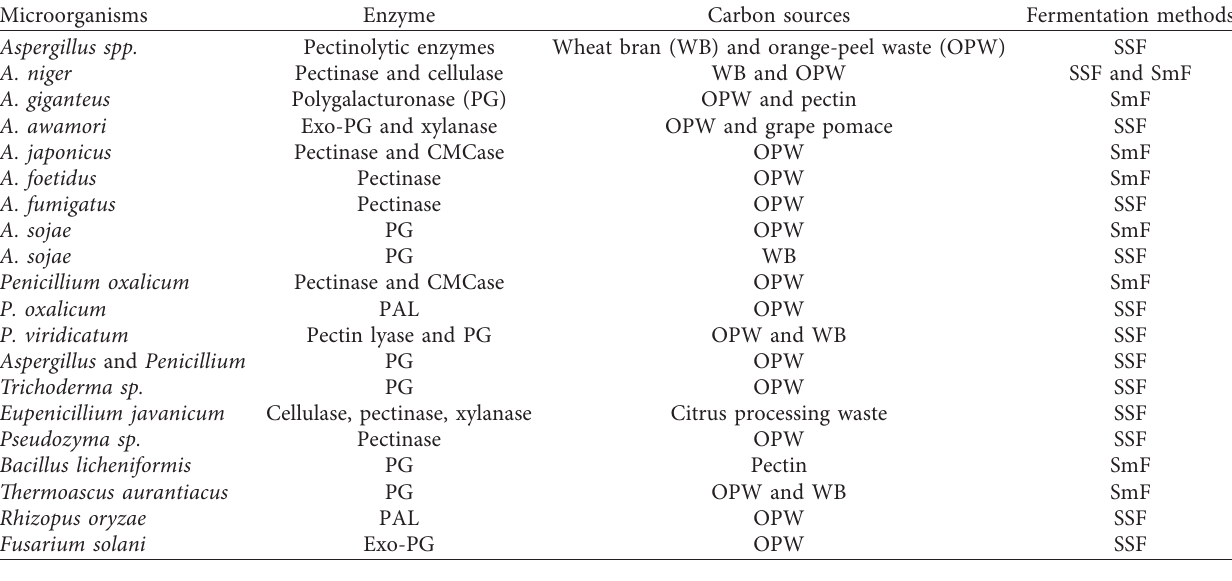
Table 5: Pectic enzyme production by numerous microorganisms and its substrate and fermentation methods [129]. Microorganisms Enzyme